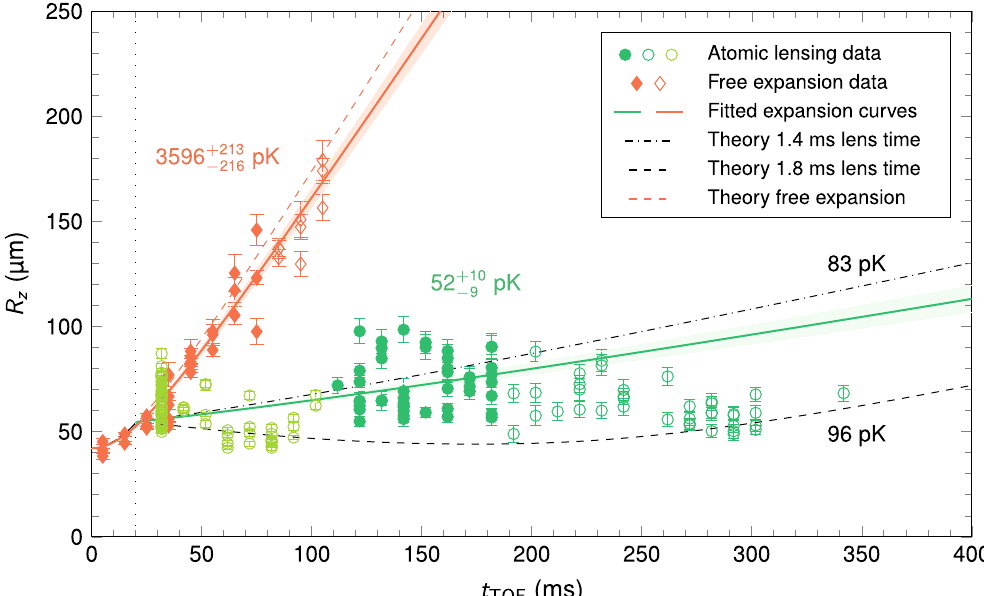
Fig.4|Delta-kickcollimationofaBECtothe50pKenergylevel. Thomas-Fermi radius in the z -direction R z of a free expanding BEC (red diamonds) released from trap A compared to the case where the fi nal trap was switched on again for 1.8ms (green dots) 20ms after release (dotted vertical line) with rescaled angular fre- quencies (by a factor 1/4) to lens the BEC. The atomic lens removes kinetic energy from the system yielding an expansion energy of only 52±10pK compared to 3.6±0.2nK for the non-lensed ensemble. The expansion energies are determined by fi ttingtheorycurves(solidlines)tothedata( fi lleddots).Shadedareasshowthe